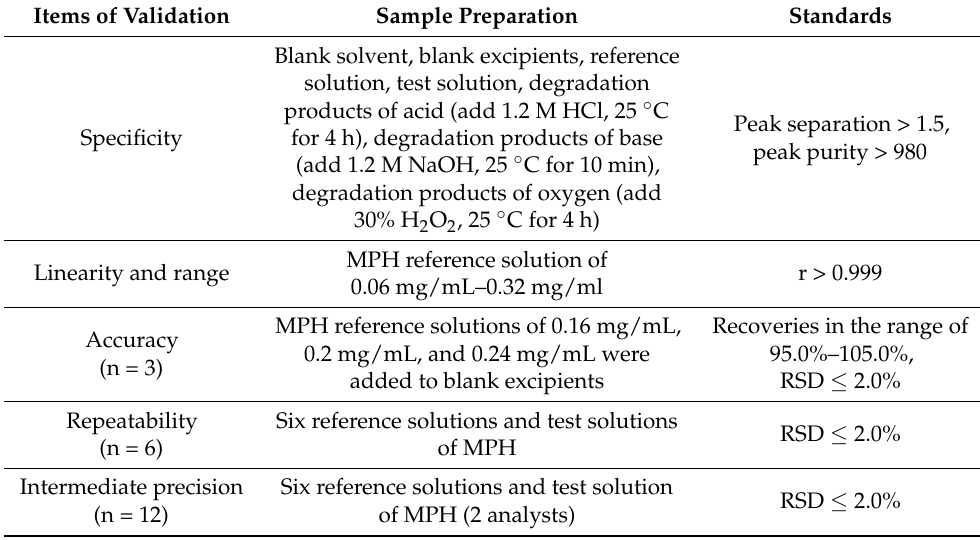
Table 3. Items of analytical method validation.